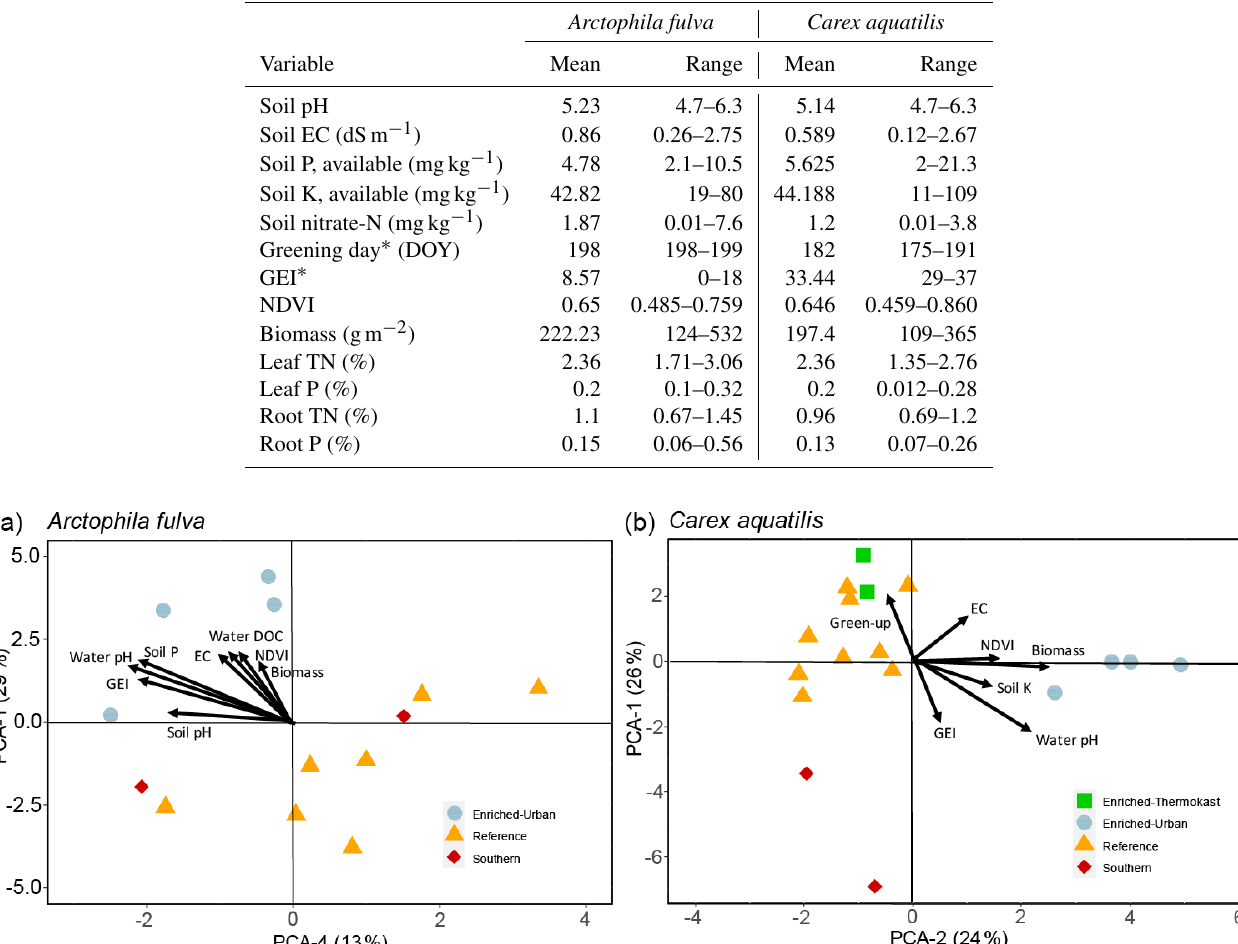
Table 1. Range of environmental variables by vegetation type from 17 ponds in Utqia˙gvik and Atqasuk, Alaska. The asterisk represents significantly different among species at p< 0 . 01. Range represents min and max.